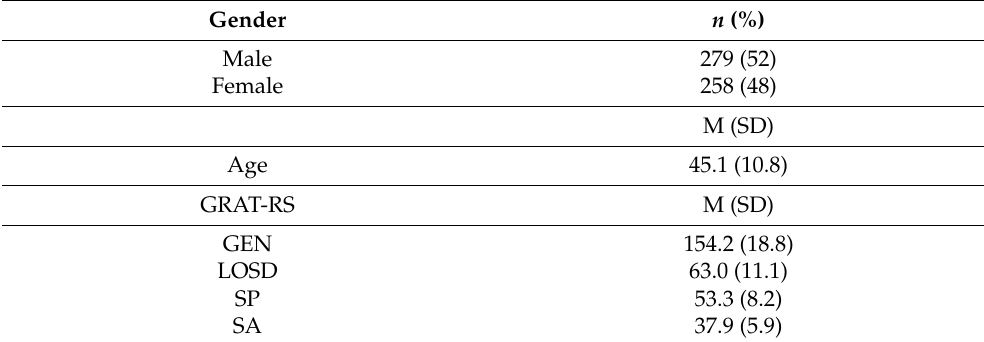
Table 1. Mean age, gender of participants, and means participants’ scores obtained at the Gratitude Resentment and Appreciation Test-Revised Short (GRAT-RS) ( n =